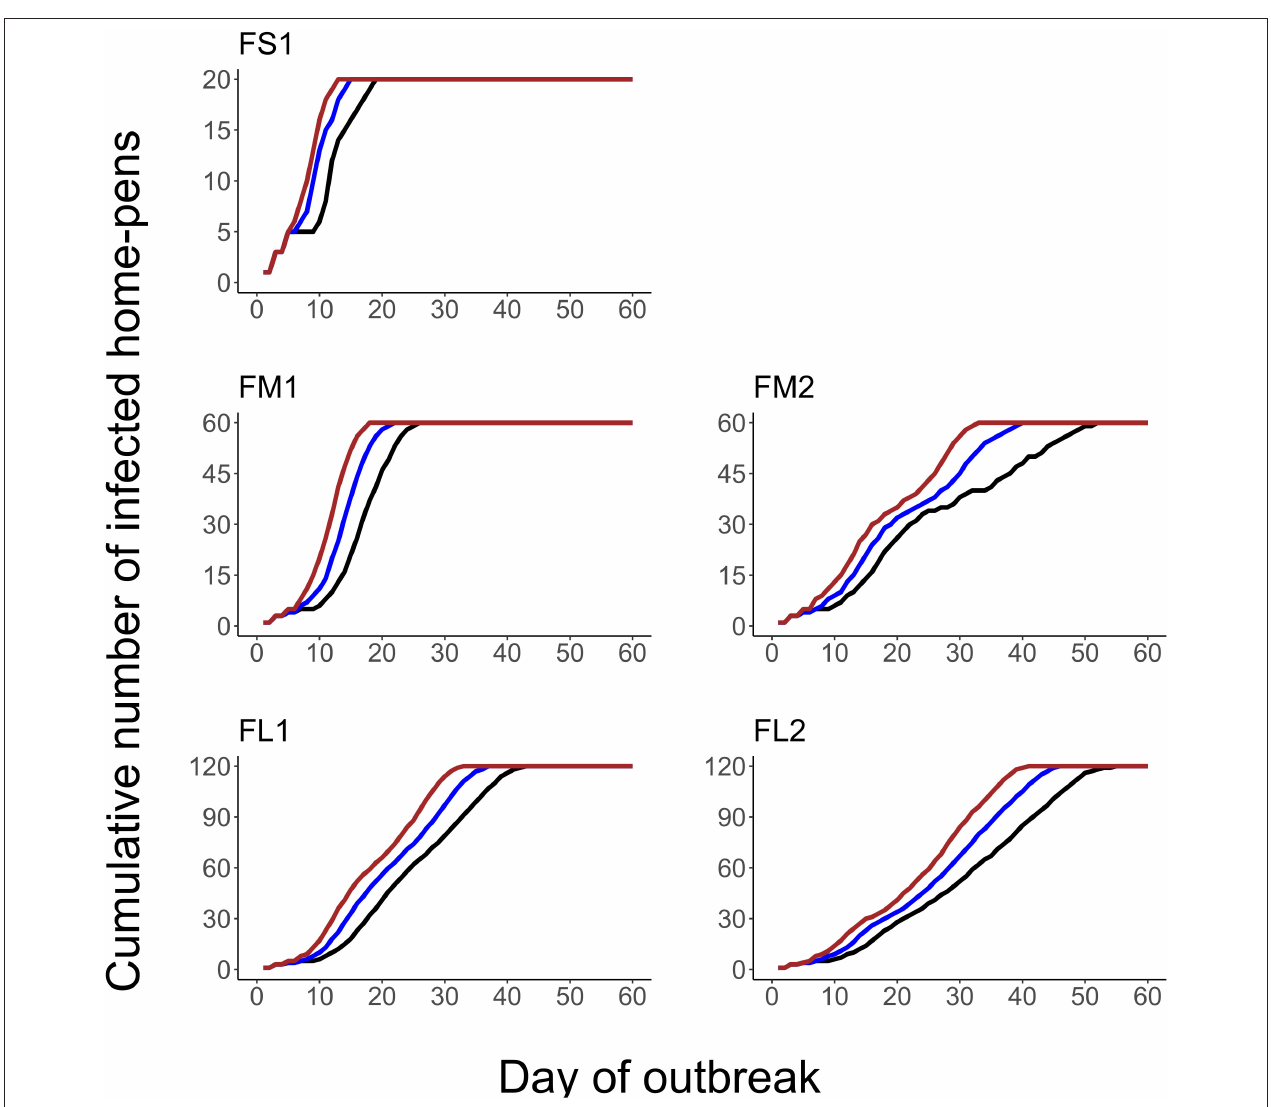
FIGURE 3 | The cumulative number of the home-pens infected with foot-and-mouth disease during a projected outbreak on a U.S. beef cattle feedlot. The lines represent the percentiles (brown lines the 90th percentile, blue lines the 50th percentile, and black lines the 10th percentile) for n = 2,000 simulated outbreaks in the feedlot of that size and layout sampling the values of the target parameters. Feedlot size and layout cases modeled: FS1 is a 4,000 cattle feedlot with one hospital-pen; FM1 is a 12,000 cattle feedlot with one hospital-pen; FM2 is a 12,000 cattle feedlot with two hospital-pens; FL1 is a 24,000 feedlot with two hospital-pens; and FL2 is a 24,000 cattle feedlot with four hospital-pens (in all the layouts n = 200 cattle per home-pen).